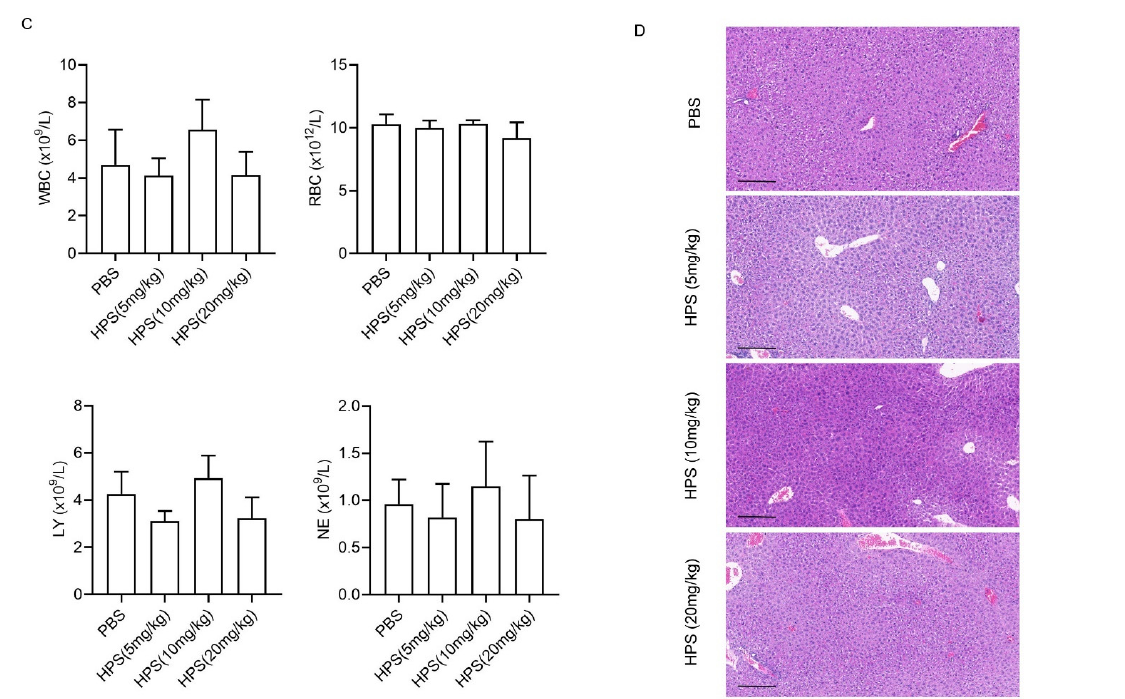
Int. J. Mol. Sci. 2021 , 22 , x FOR PEER REVIEW 14 of 21 Figure 6. Effects of a single dose of HPS on tissue injury in mice. BALB/c male mice at 8 weeks of age were intravenously injected with various amounts of HPS (5.0, 10.0, or 20.0 mg/kg) or PBS ( n = 5/group). Seven days later, primary safety evaluation was analyzed. ( A ) Body weight. ( B ) Serum ALT, AST, BUN, CREA, and CK levels. ( C ) Routine blood tests. ( D ) Liver tissues were fixed, sectioned and stained with H&E for histopathological and morphological analysis. Scale bar, 200 µ m.